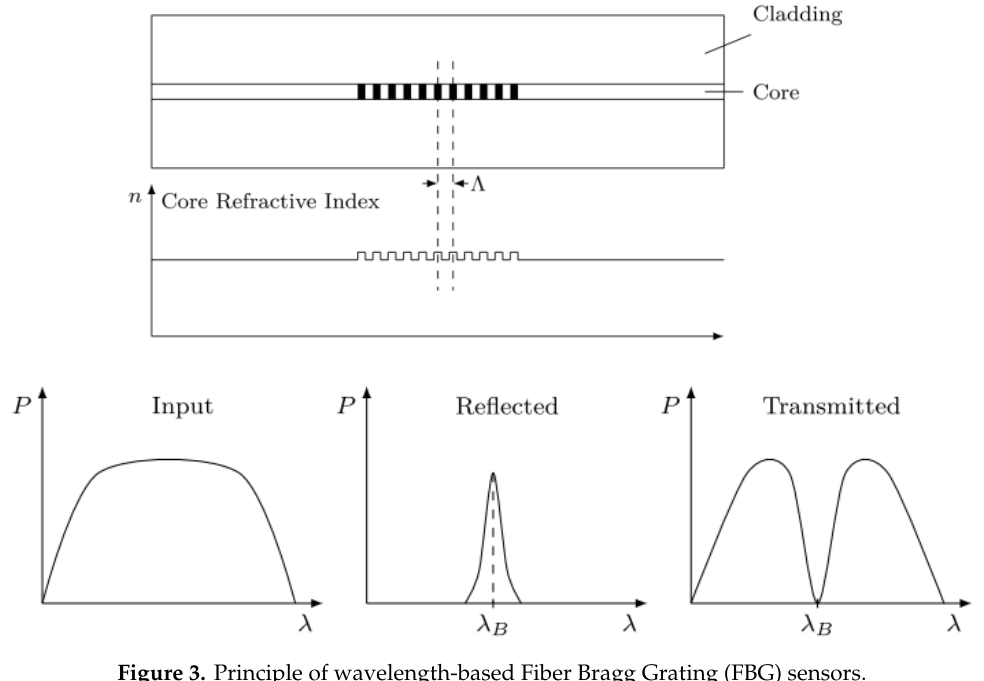
Figure 4. Principle of wavelength-based Fiber Bragg Grating (FBG) sensors. Figure 3. Principle of wavelength-based Fiber Bragg Grating (FBG) sensors.